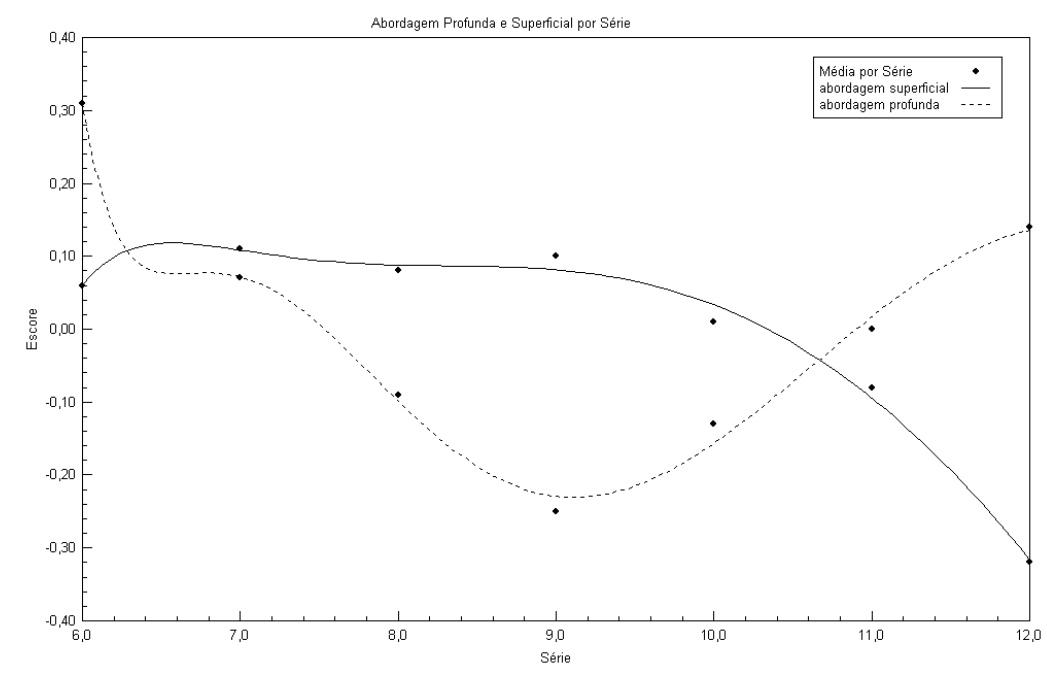
Figura 1 . Média de desempenho nas abordagens por